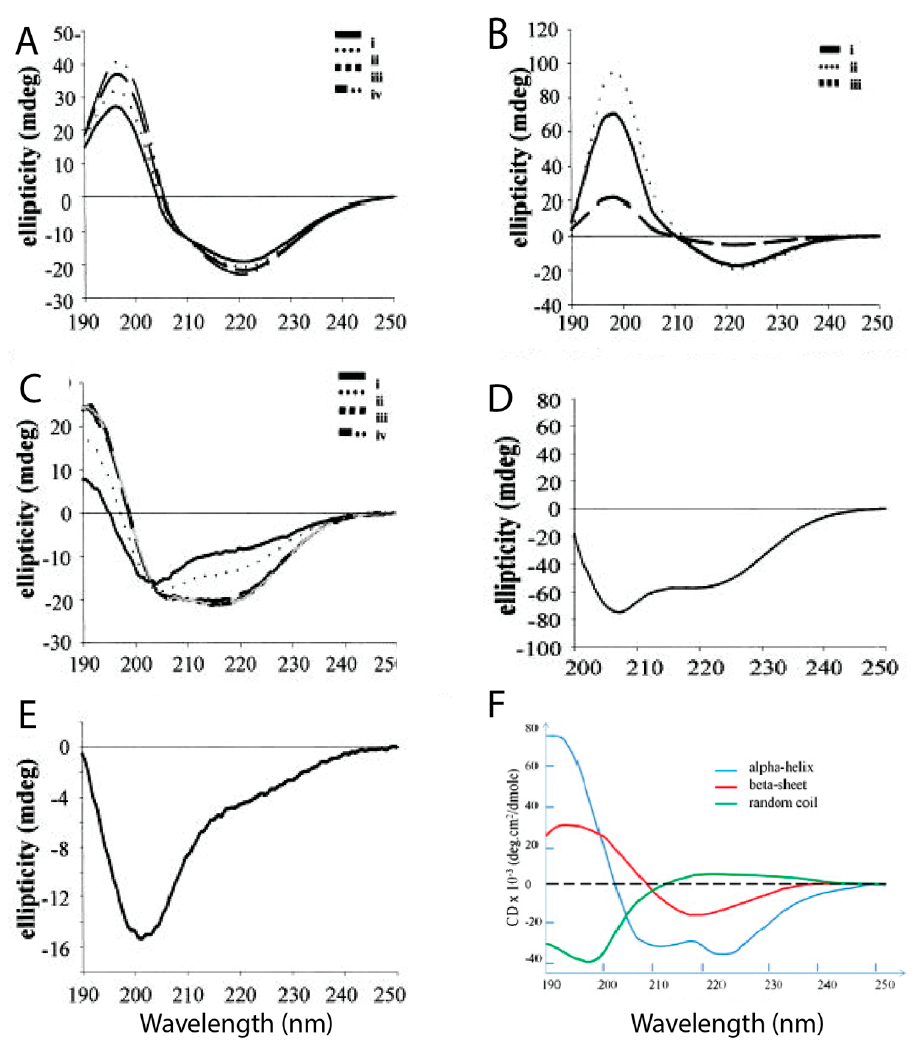
Figure 4. Circular dichroism (CD) spectra of human and rat IAPP in different preparations. ( A ) hIAPP in water at 0, 2, 8, and 24 h shows both α -helical and β -sheet contents, with an increase in β -sheet content over time, as seen by the increase in the peak at 200 nm; ( B ) hIAPP in 60% TFE at 0 h, 6 h, and 7 days shows an increase in β -sheet content over time; ( C ) hIAPP in 1% HFIP at 0 h, 10 min, 30 min, and 3 h is less stable and gradually converts from α -helical to β -sheet with time; ( D ) hIAPP in 10% HFIP after seven days is largely α -helical, as revealed by the curve in the 210–250 nm range ( E ) rIAPP in water after seven days shows a mostly random coil conformation; ( F ) reference curve for the ellipticity of α -helix, β -sheet, and random coil over different wavelengths. Adapted from Higham et al. [39]. Copyright (2000) John Wiley and Sons.